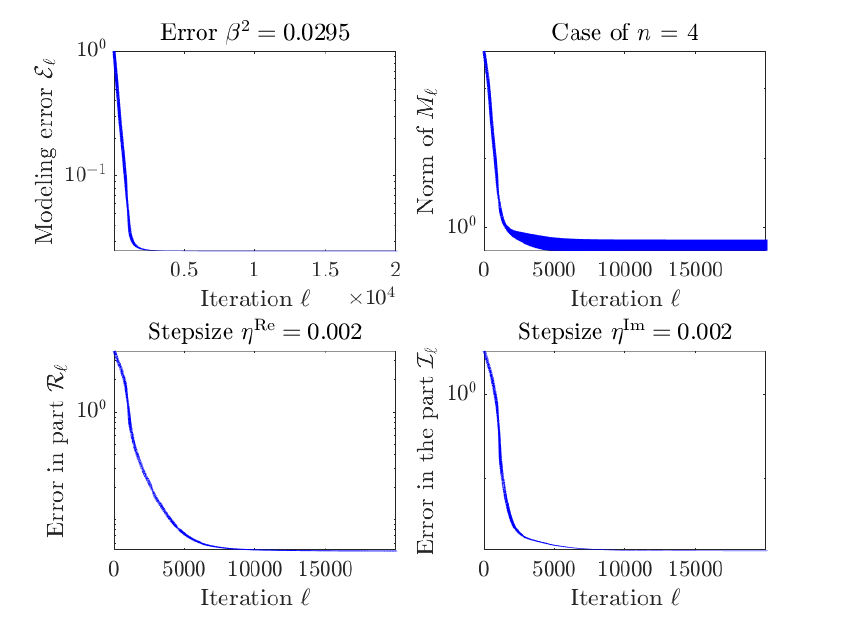
Figure 8. Results of a numerical experiment with n =